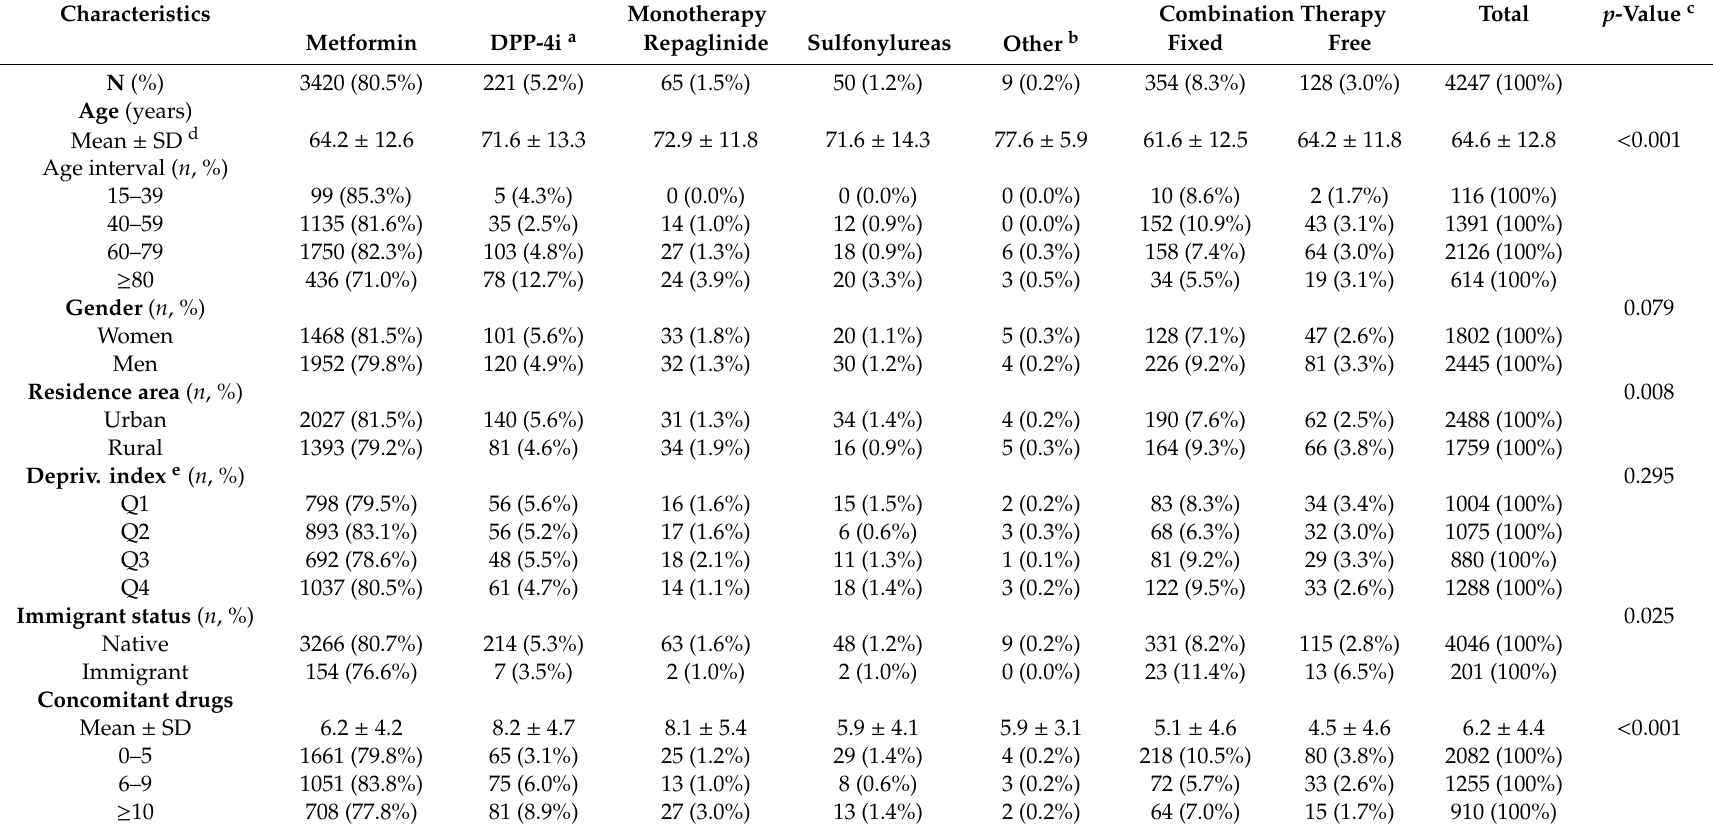
Table 1. Demographic and clinical characteristics of new users of oral antidiabetic drugs at cohort entry (objective i).